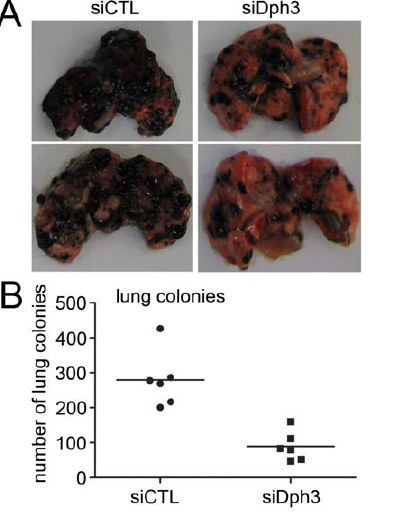
Figure 5. The metastasis of mouse melanoma B16 F10 was impaired by Dph3 silencing in vivo. siCTL and siDph3 cells were injected into the lateral vein of C57BL/6J mice respectively. A, representative pictures of lungs from mice were taken after 2 weeks of injection with B16F10 control cells or with Dph3 KD cells. B, numbers of lung metastasis were quantified and showed by each data point, **p , 0.01, compared to control cells.